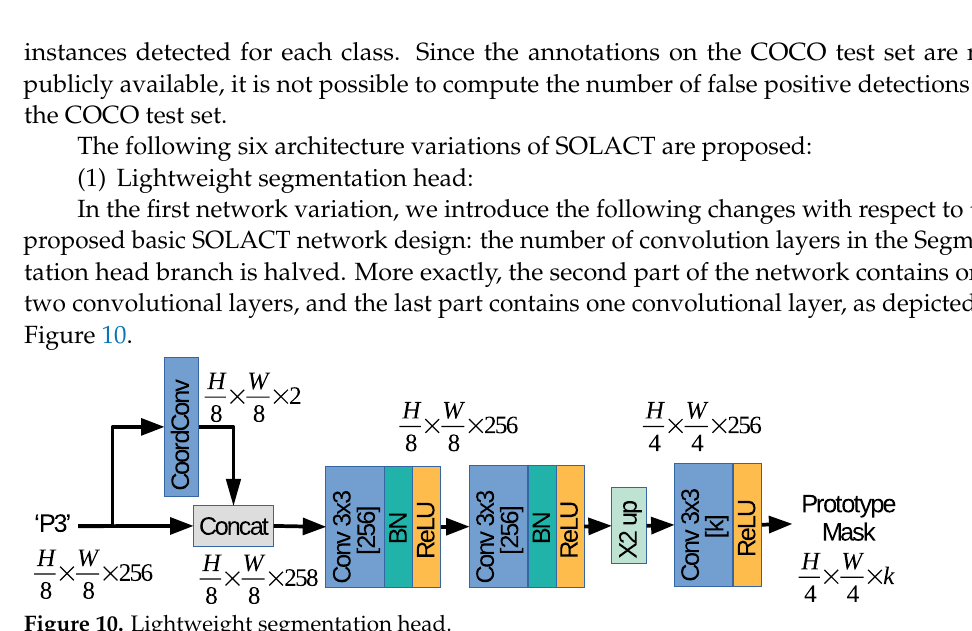
Figure 10. Lightweight segmentation